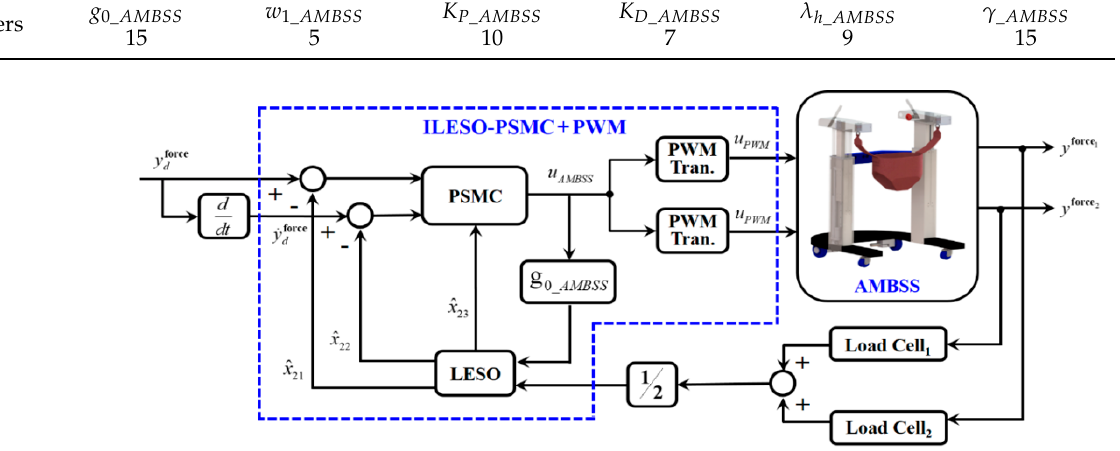
Figure 5. Control block of the AMBSS.